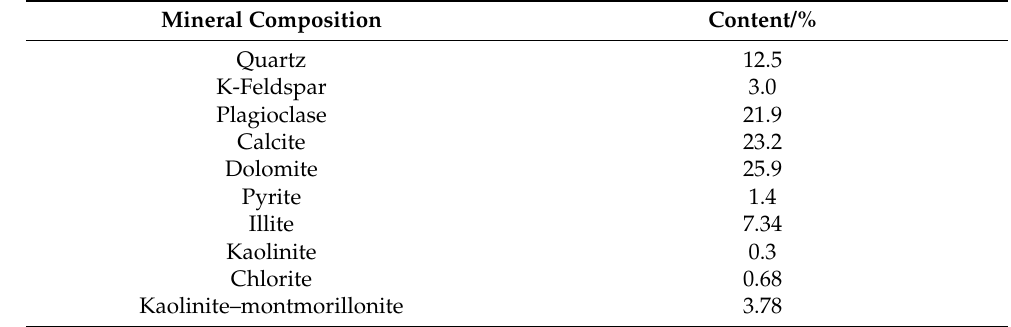
Table 1. Mineralogical composition of shale